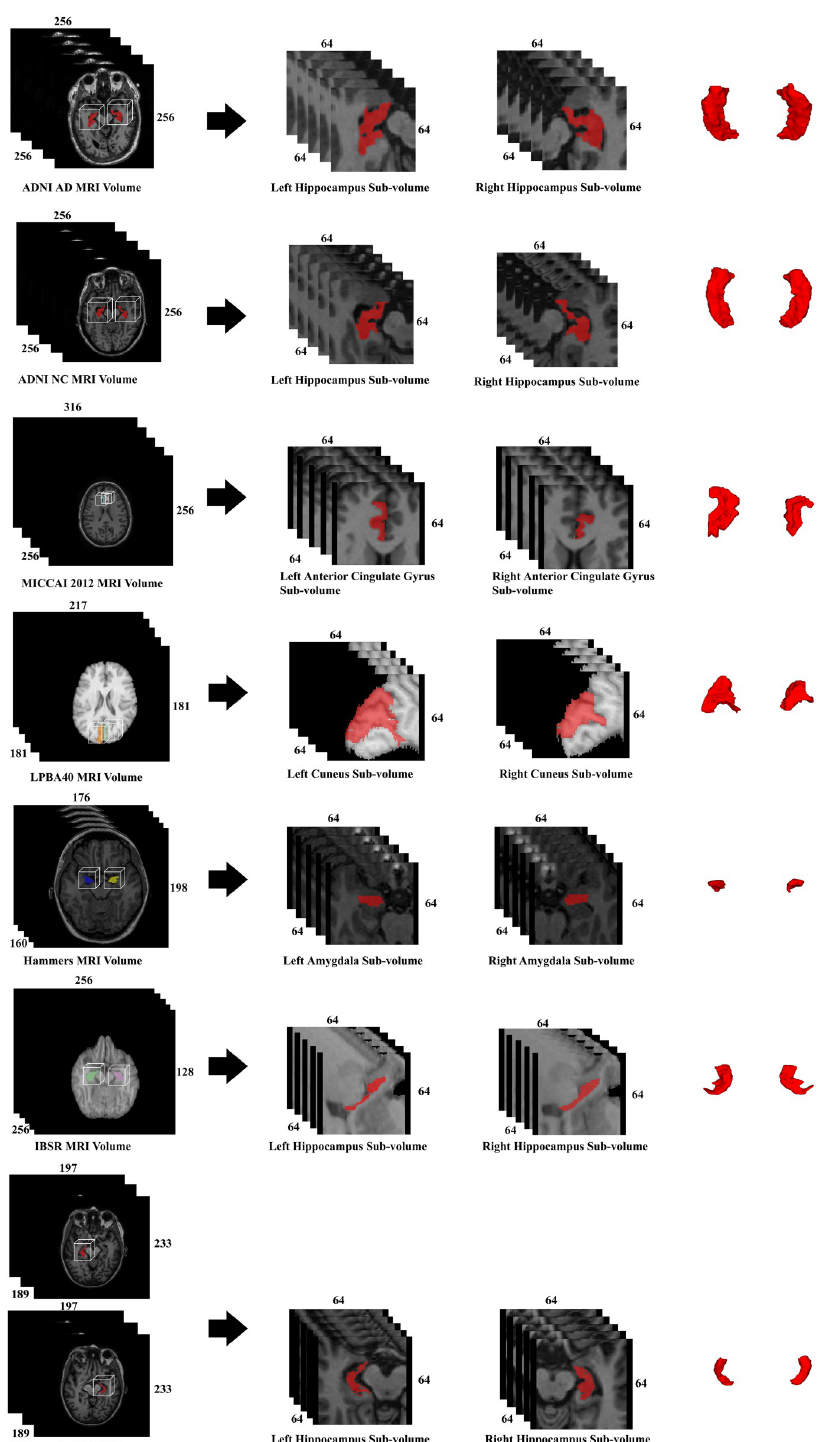
Fig 5. Volume examples of the datasets in our experiments. For each MRI volume, we extract the left and right sub- volumes of some brain structure to obtain a dataset of cropped volumes according to ROIs generated by Freesurfer. The dimensional length is annotated alongside the volumes shown in stacked